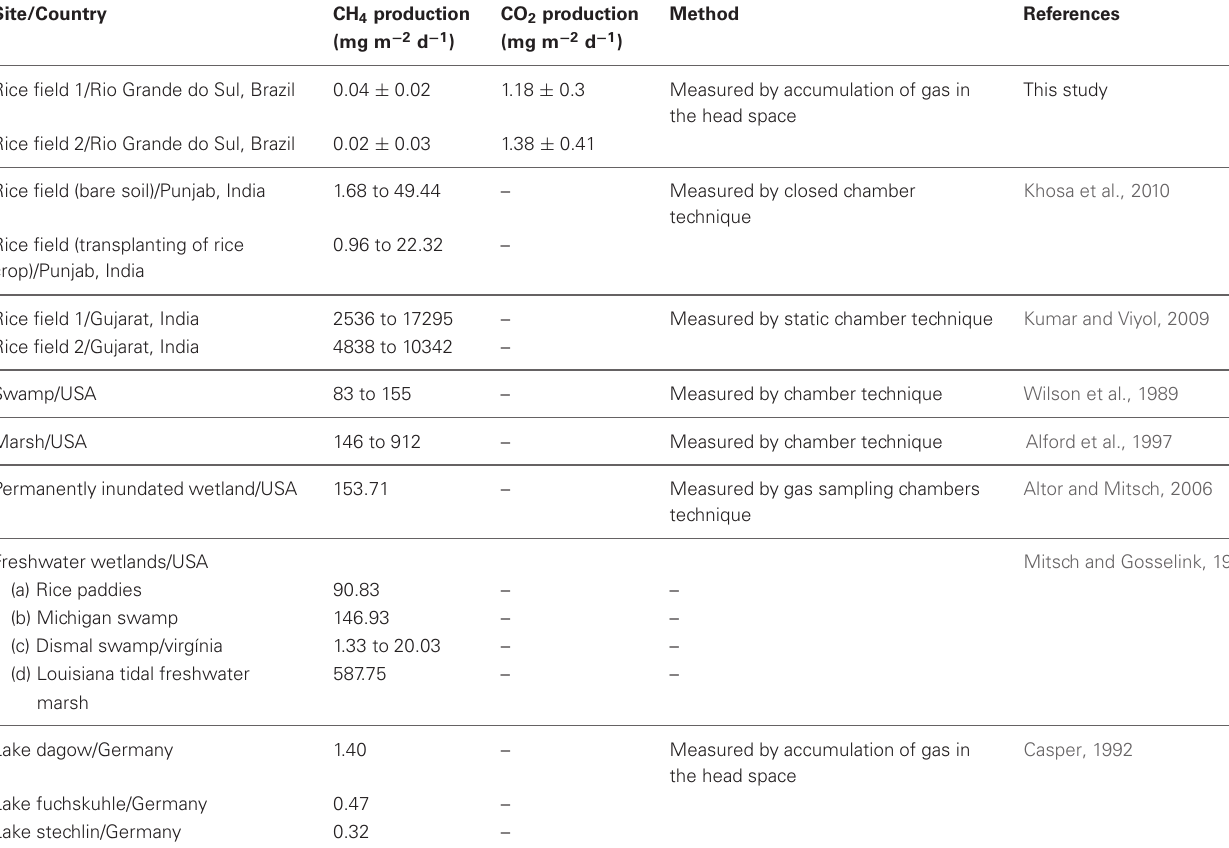
Table 3 | Rates of CH 4 and CO 2 production in soils intermittent or permanently